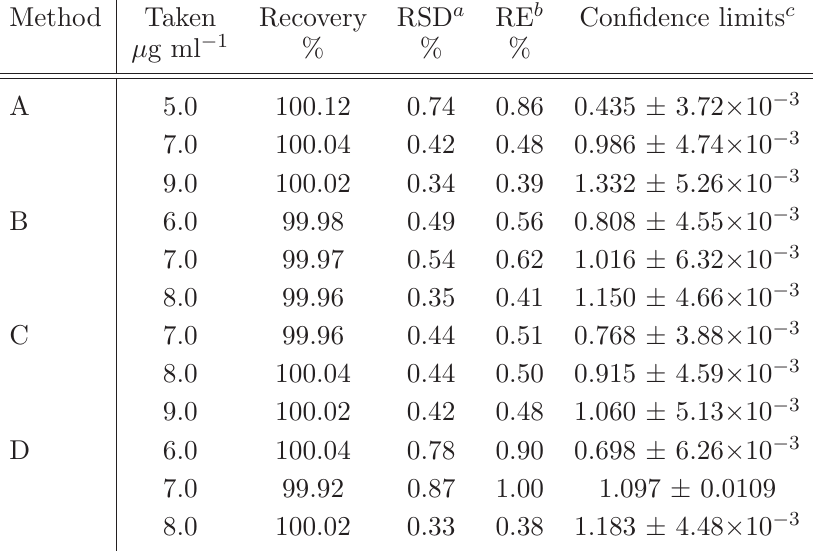
Table 3 Evaluation of accuracy and precision of the proposed methods with gentamicin sulphate.